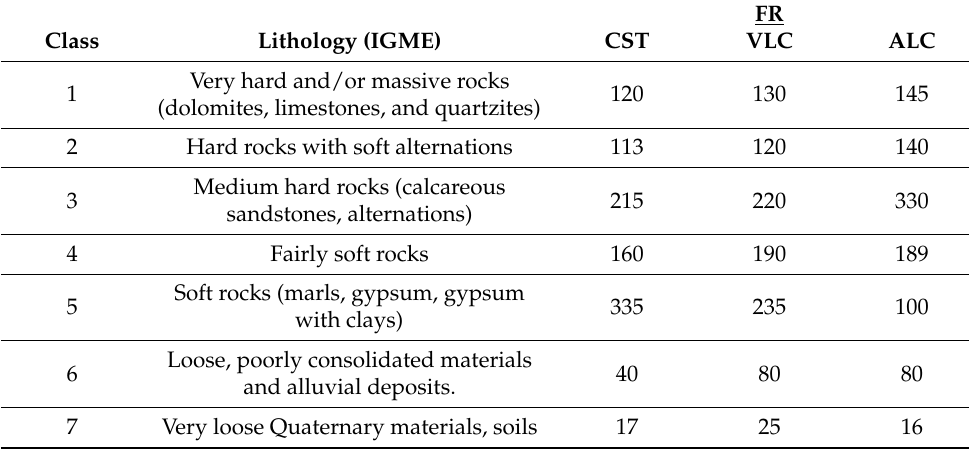
Table 3. Lithology classes defined by the authors according to Geological and Mining Institute (IGME) data. Provinces of Castellon (CST), Valencia (VLC), and Alicante (ALC).